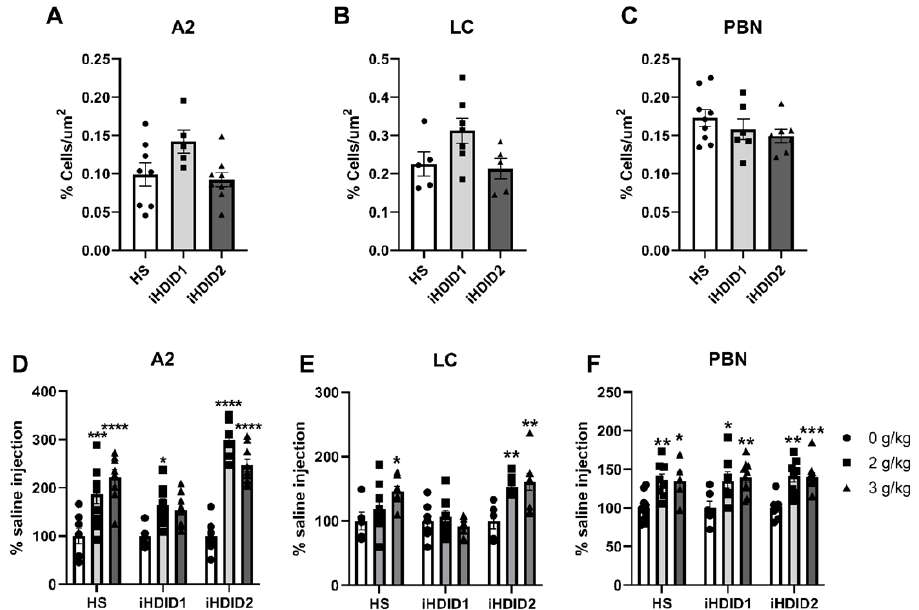
Figure 1. C-Fos Levels in the Hindbrain. ( A – C ) No difference in saline-induced c-Fos activation was detected between genotypes in any area. ( D ) Ethanol induced increased c-Fos levels in the A2 at all doses in the HS and iHDID2, but not at the 3 g / kg dose in the iHDID1 line. ( E ) Ethanol induced changes in c-Fos levels relative to saline in the HS and iHDID2, but not iHDID1 in the LC. ( F ) Ethanol induced increased c-Fos levels in the PBN in all genotypes. * p < 0.05, ** p < 0.01, *** p < 0.001, **** p < 0.0001 from two-way ANOVA Tukey’s multiple comparisons test.